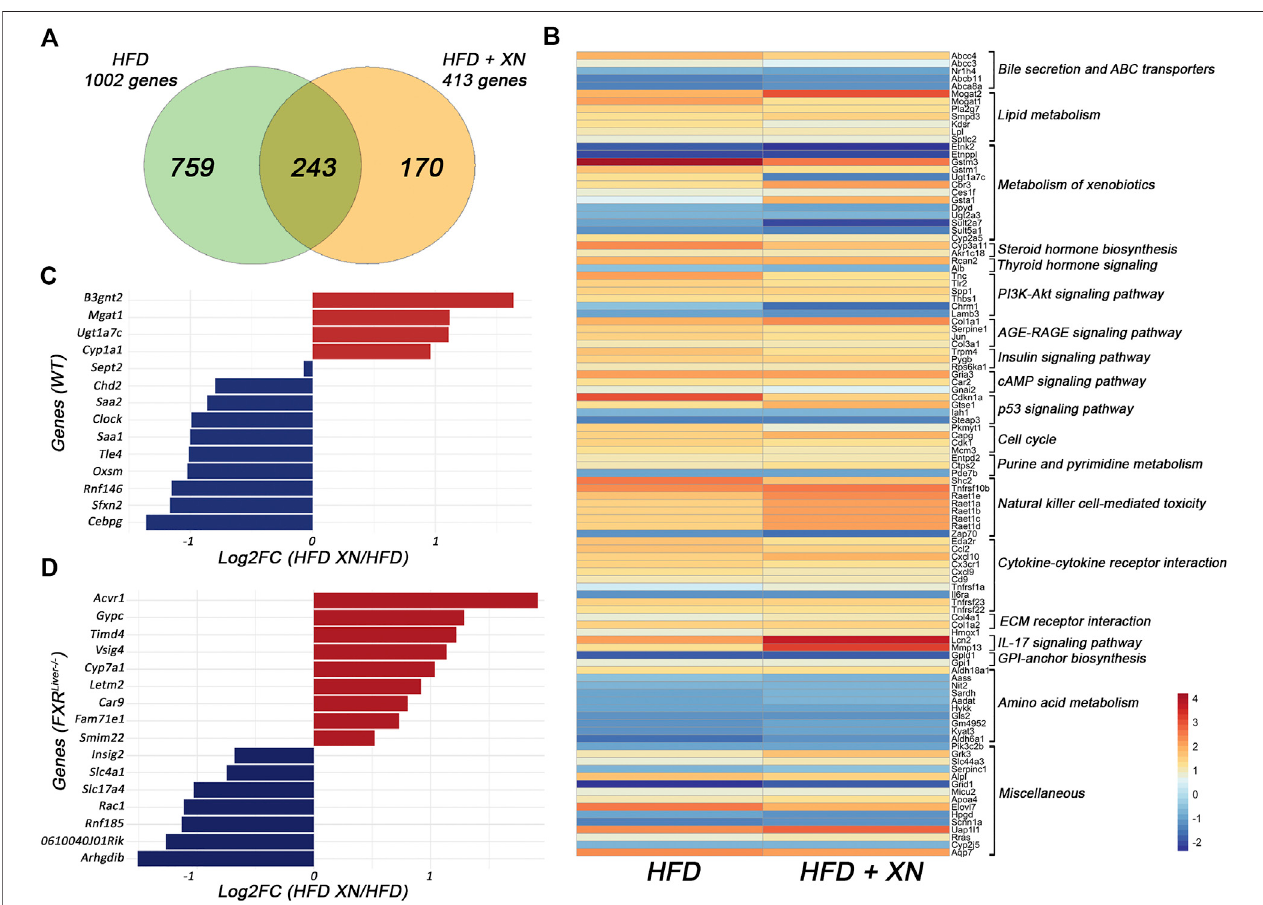
FIGURE 5 | XN alters hepatic gene pro fi les (A) Venn diagram comparing genes in HFD-fed mice vs. HFD-fed mice treated with XN (B) Relative expression of 106 shared genes classi fi ed according to KEGG pathway (Log2FC of FXR Liver − / − ± XN/WT) (C) Genes regulated by XN in WT mice (D) Genes regulated by XN in FXR Liver − / − mice. Values are mean of n (cid:2) 4-5 mice (males and females) per